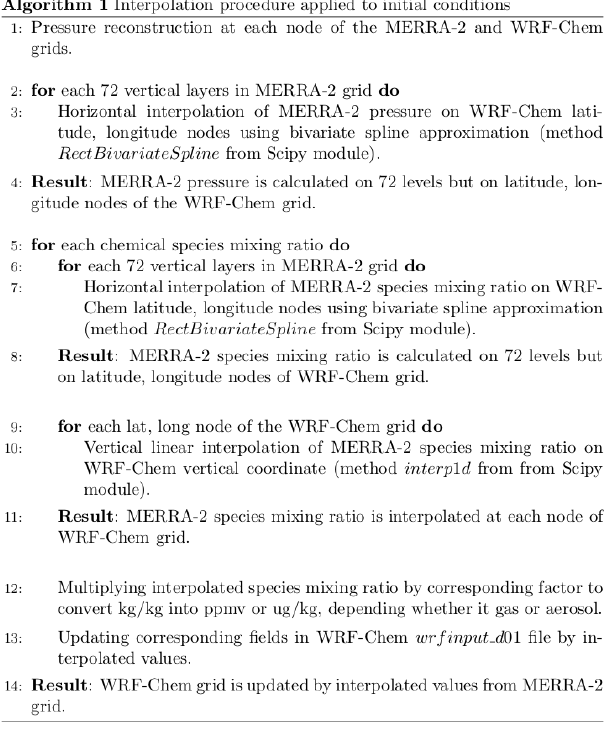
Figure A2. Interpolation procedure applied to initial